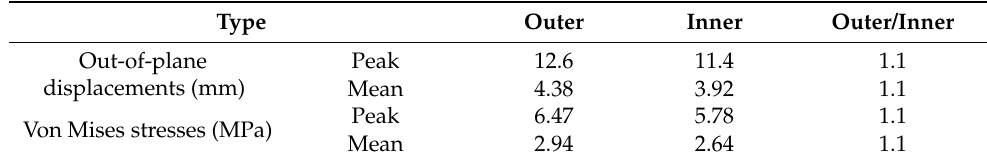
Figure 6. Response distribution of the independent LGCW at 0° and 90°.